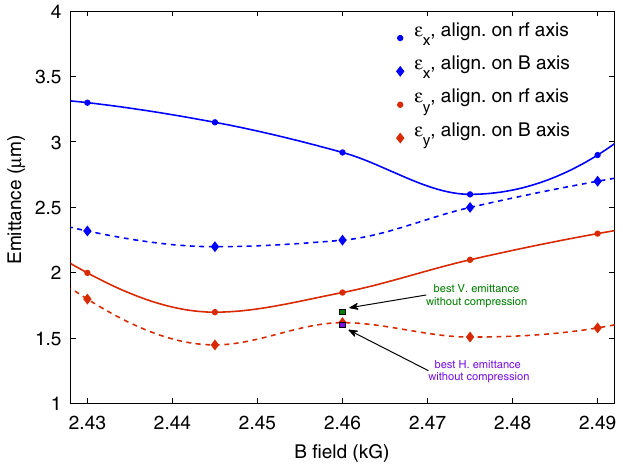
FIG. 13. Projected emittance of compressed beam as a function of gun solenoid field, for two different beam orbits along the linac. Dots represent emittance with beam orbit on the electromagnetic center of the cavities. Diamonds show the same measurements after the beam orbit has been reoptimized on the magnetic axis of the solenoids. As a comparison, horizontal and vertical projected emittance without compression are also